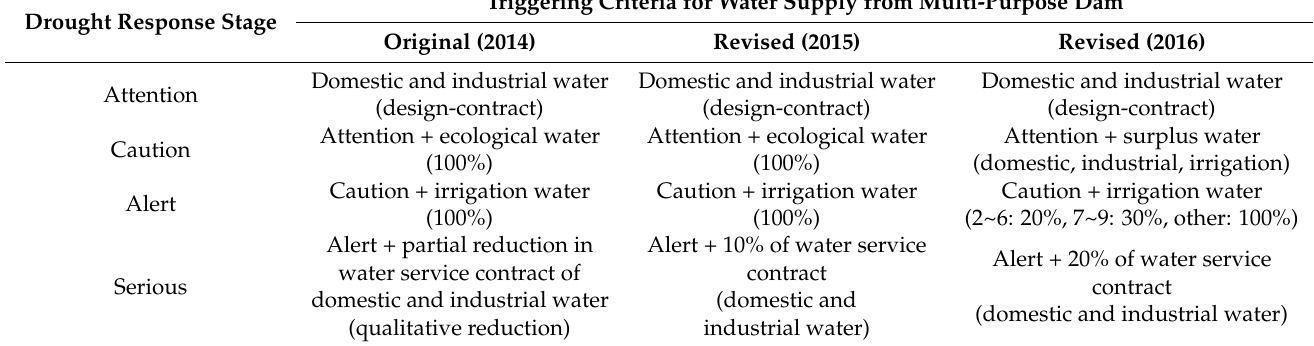
Table 2. Comparison of Triggering Criteria for Water Supply from Multi-purpose Dams by Drought Response Stages